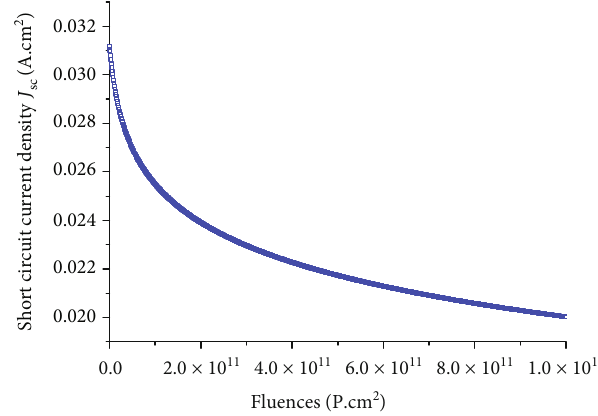
= 0 : 02 cm ; 0 = 27cm 2 : s − 1 ; H = 0 : 03 cm ; n